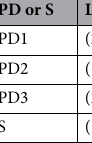
Table 2. Location of the considered PD sources and single UHF sensor inside the power transformer tank.